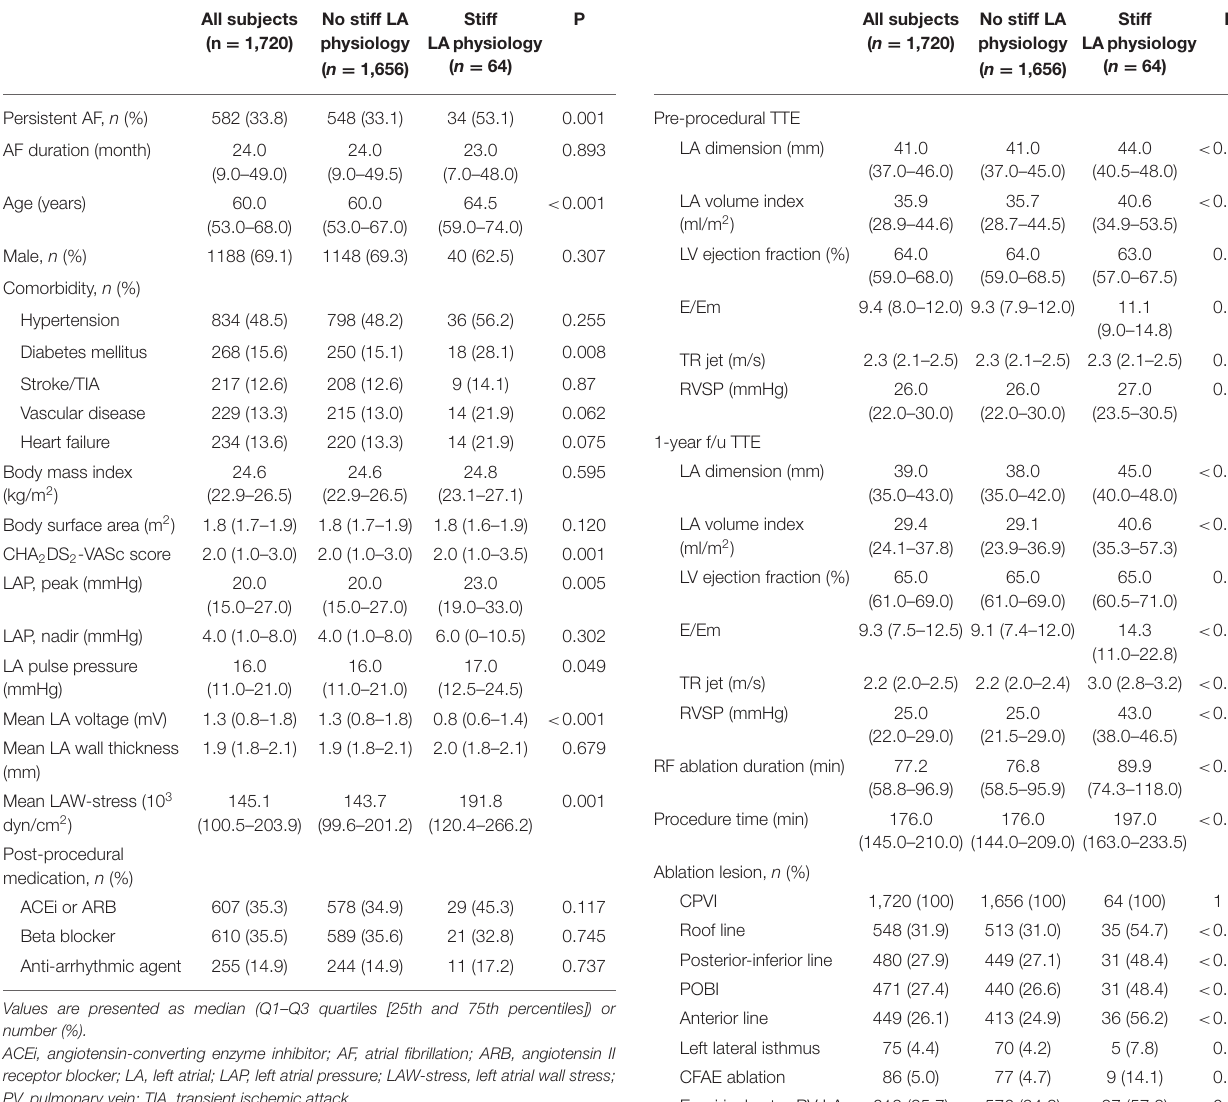
TABLE 1 | Baseline characteristics according to the occurrence of stiff LA physiology.